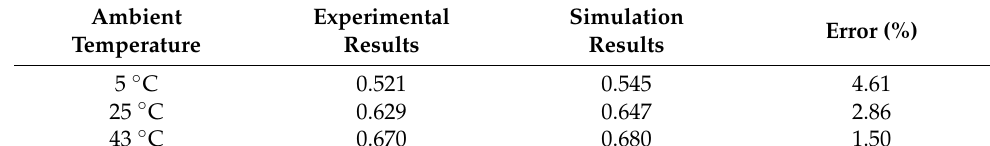
Table 5. Accuracy of the quality simulation results within the evaporator middle part.